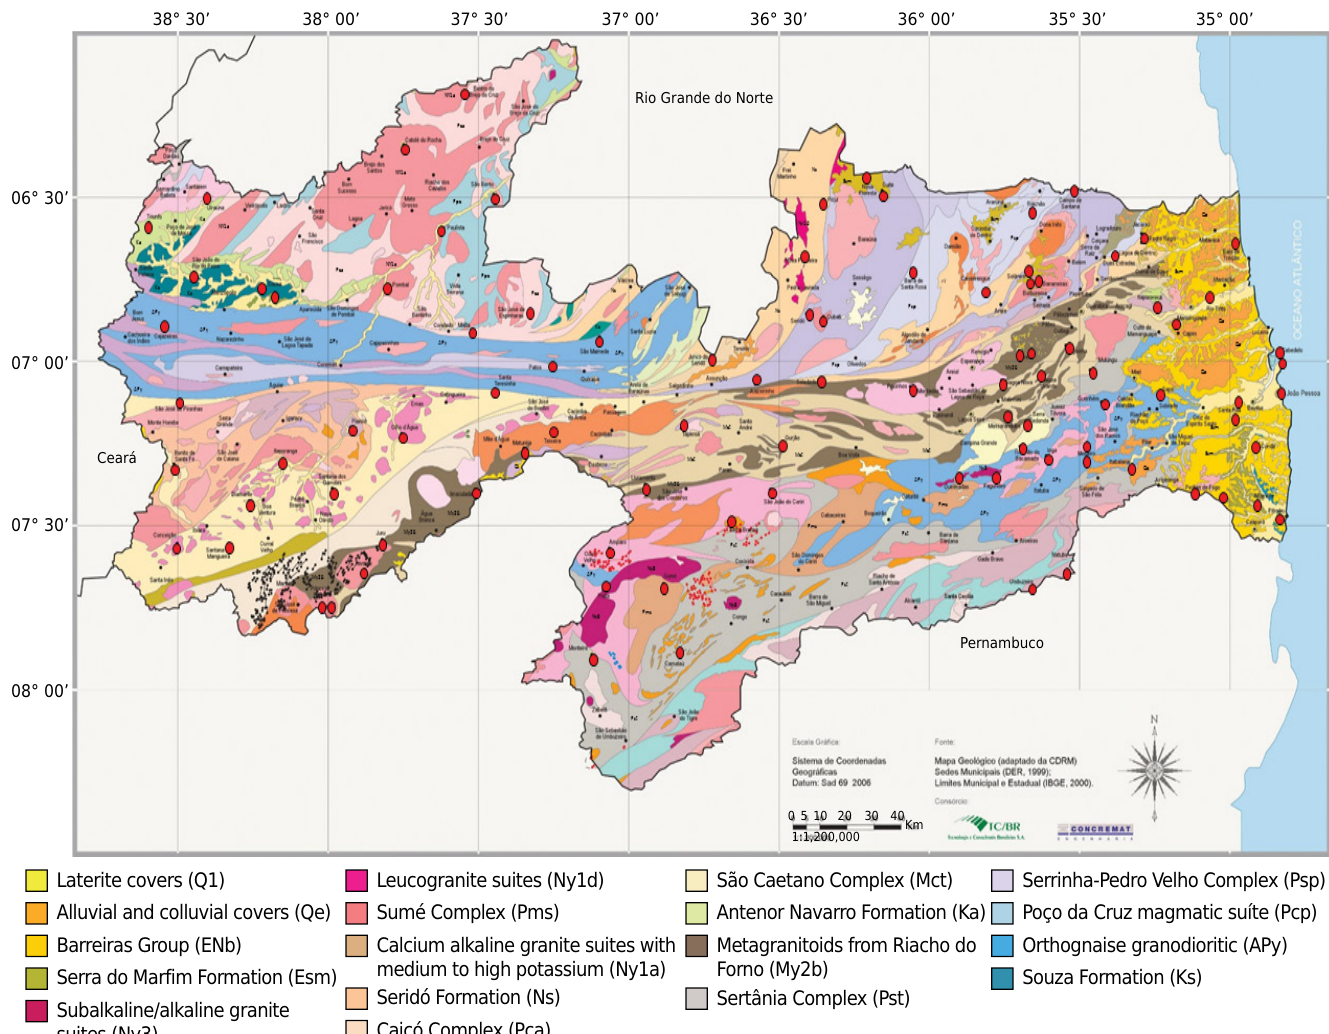
Figure 1. Geological map of Paraíba state (Brazil) showing the sampling locations (CPRM, 2002, modified).